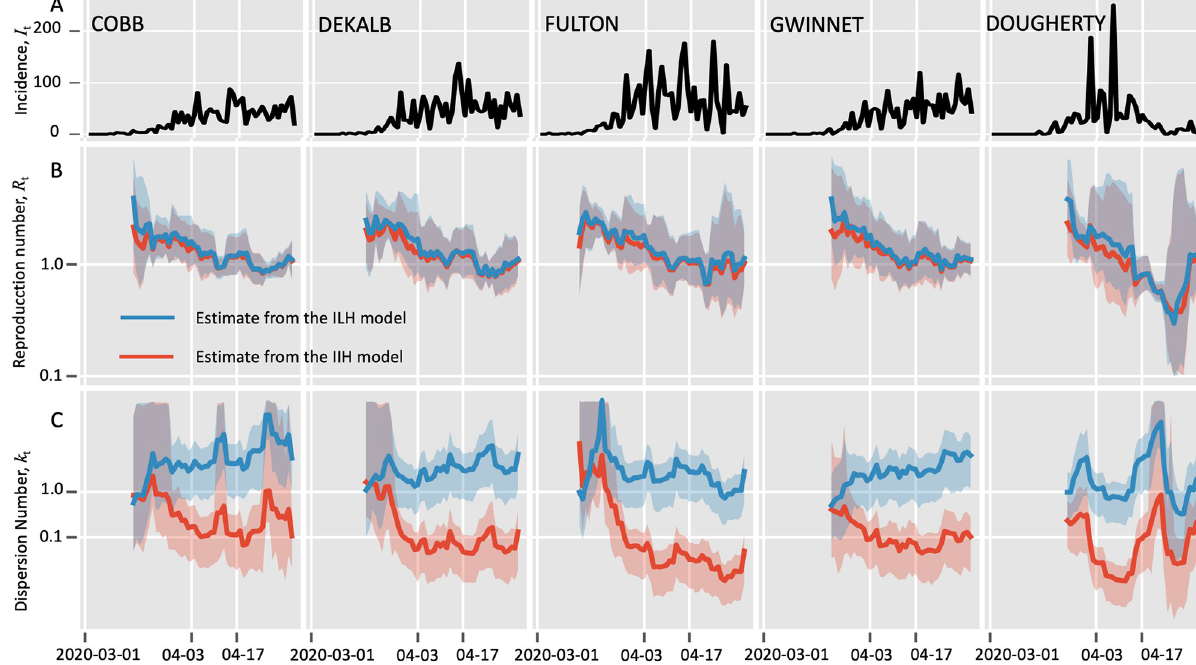
Fig 4. Comparison of estimating real-time transmission dynamics of the COVID-19 epidemic between March 1, 2020 and May 3, 2020, in five counties of Georgia state, USA. Transmission dynamics (i.e., reproduction number R and dispersion number k ) were assumed constant over a window of 7 days, and the estimates were obtained by analyzing the incidence data of the time window. Solid lines show the mean estimates from two methods, i.e., red curves and blue curves represent the estimation from the instant-individual heterogeneity model (IIH) and the instant-level heterogeneity (ILH) model respectively. The shaded areas show the 95% high probability density (HPD) intervals. As in [9], the reference time was set as April 3rd, 2021 when the shelter-in-place order was announced. The whole study period was divided into three periods, i.e., before April 3rd, between April 3rd and April 17th, after April 17th. A: Incidence data of the confirmed and probable cases; B: Estimation of reproduction number ( R t ); C: Estimation of dispersion number ( k t